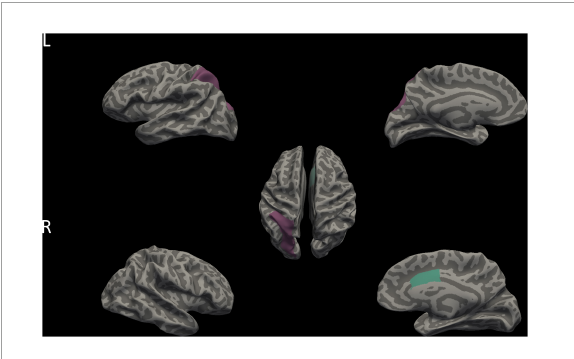
FIGURE3 Differences in LGI among AVH, non-AVH, and HC groups. Purple and aqua green indicates two brain regions with significant differences in LGI among three groups ( p < 0.05, corrected for multiple comparisons with LSD). L, left; R, Right.